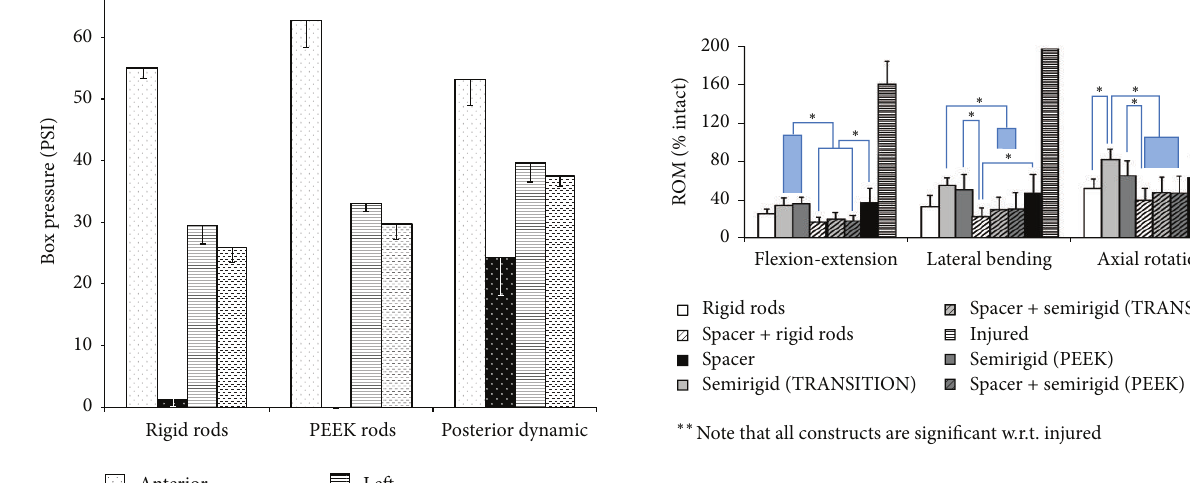
Figure 11: The biomechanical flexibility results normalized to intact motion (100%) by mode. Statistical indicators are shown with